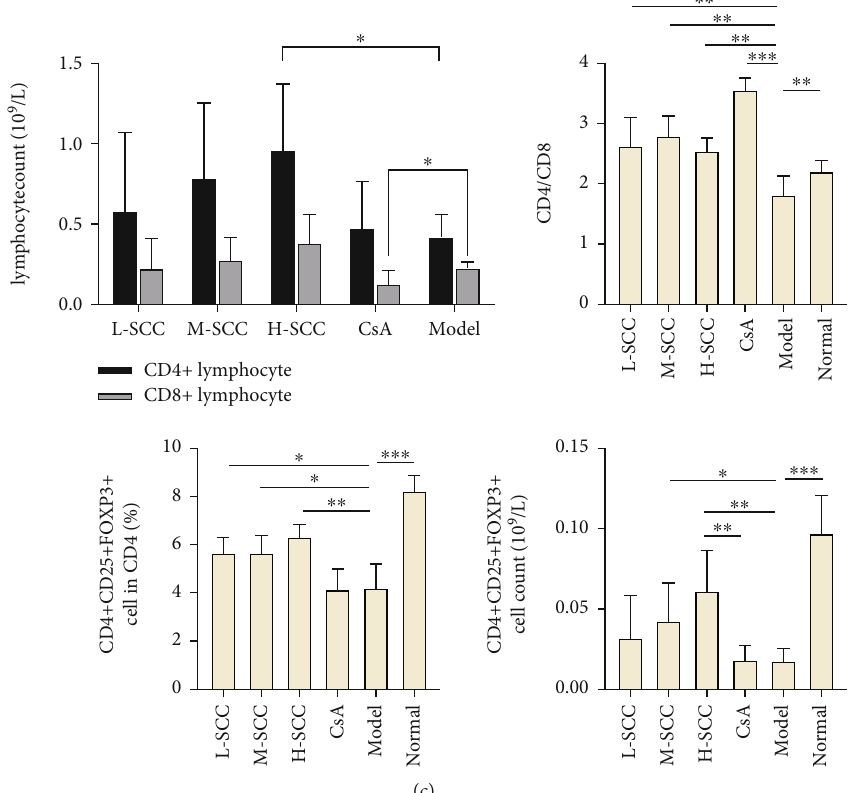
Figure 2: Comparative analysis of peripheral T cell subsets. (a) A representative dot plot of CD8 and CD4 in each group of rats. (b) By fl ow cytometry, we de fi ned the subpopulation of CD4+CD25+ cells expressing FOXP3 as Treg cells, with the presentation of typical data for di ff erent groups. (c) Comparative of CD4/CD8, absolute values of CD4+ and CD8+ cells and the percentages of Treg in rats of each group ( n = 6 ); a, L-SCC group; b, M-SCC group; c, H-SCC group; d, CsA group; e, model group; f, normal group. Statistically signi fi cant di ff erences are indicated by ∗ P < 0 : 05 ; ∗∗ P < 0 : 01 ; ∗∗∗ P < 0 : 001